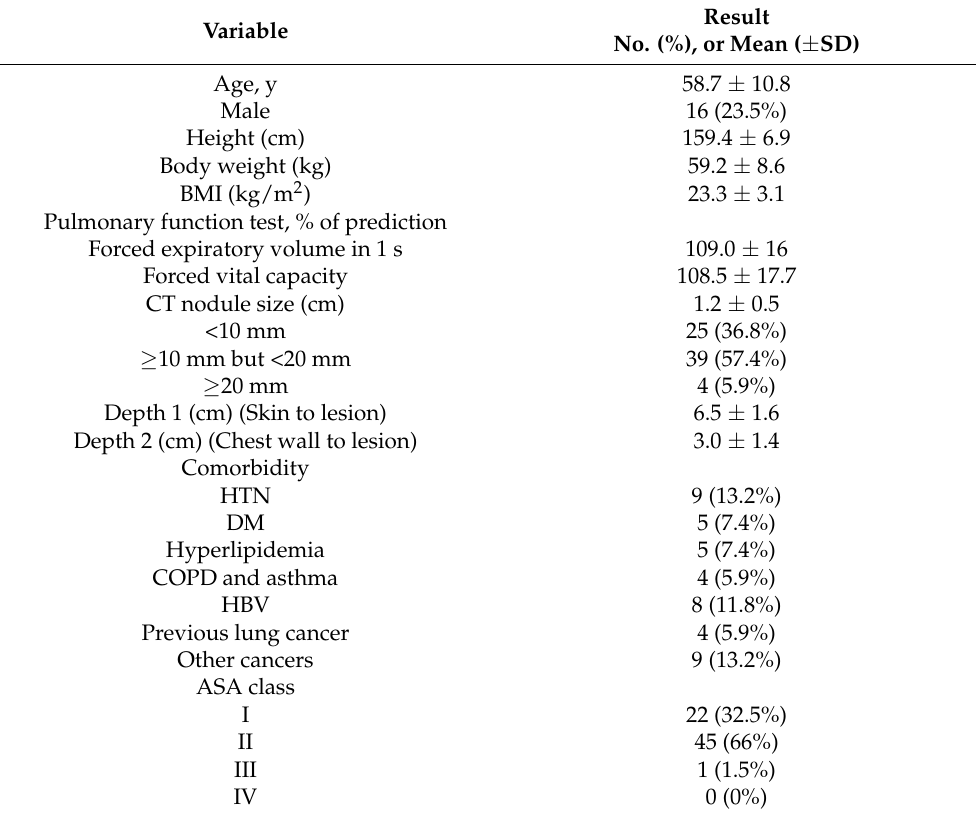
Table 1. Demographic and clinical